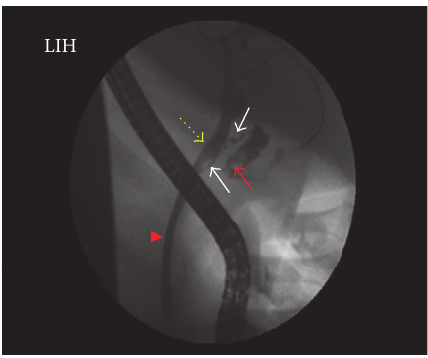
Figure 1: ERCP shows Mirizzi syndrome (arrow head: ductus choledochus, yellow dotted arrow: dilated common hepatic duct, white arrows: cystic duct, and red arrow: gallstones in Hartmann’s pouch).